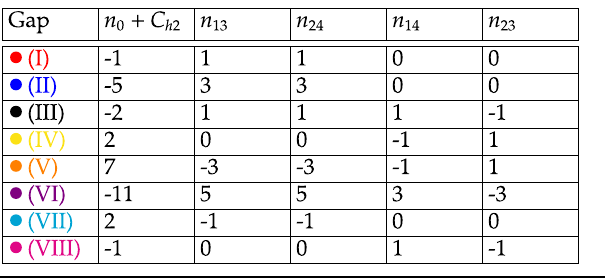
Table 3 Gap labeling for β ¼ π =